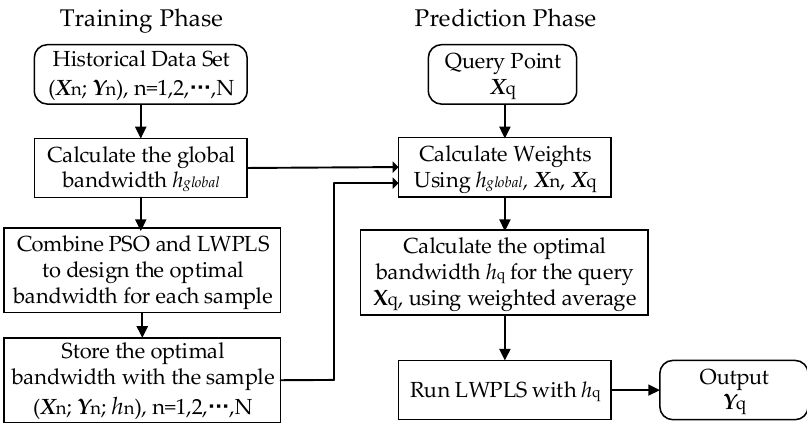
Figure 3. Framework of the proposed two-phase strategy.